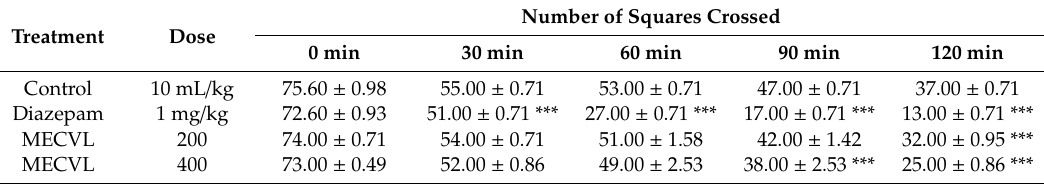
Table 3. E ff ect of MECVL in the open field test.